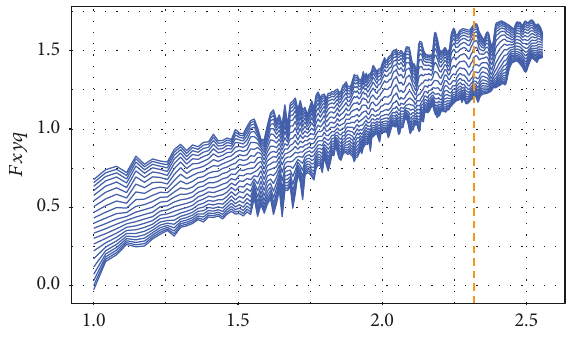
Figure 4: Log-log plots of 𝐹 𝑥𝑦𝑞 (𝑠) versus 𝑠 for amount of MM news and the return of SSE 50.